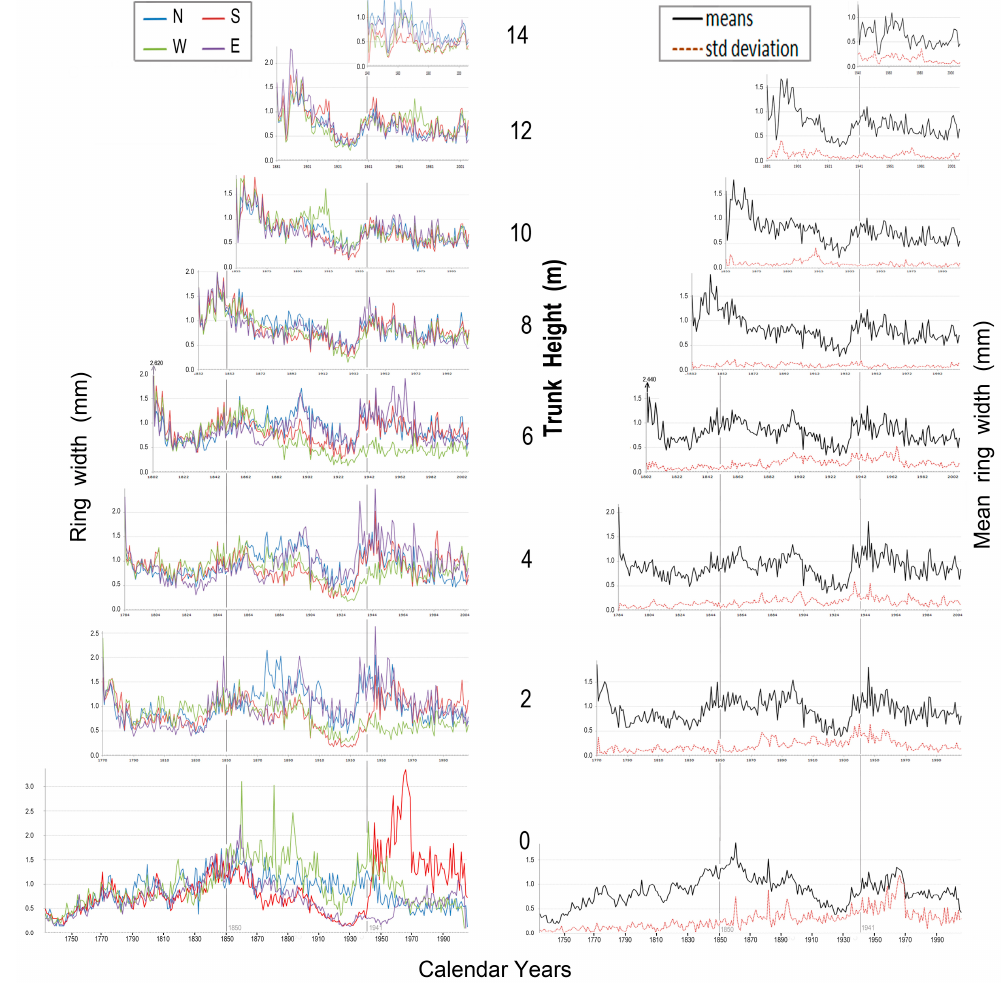
Figure 16. Tree 1316, left panel: ring widths of the four cardinal directions at 8 trunk heights (2 m apart); right panel: means of the four cardinal directions and their standard deviations. (Note: heights shown for tree 1311 (Figure 11) are 1 m apart whereas 2 m height separations are used